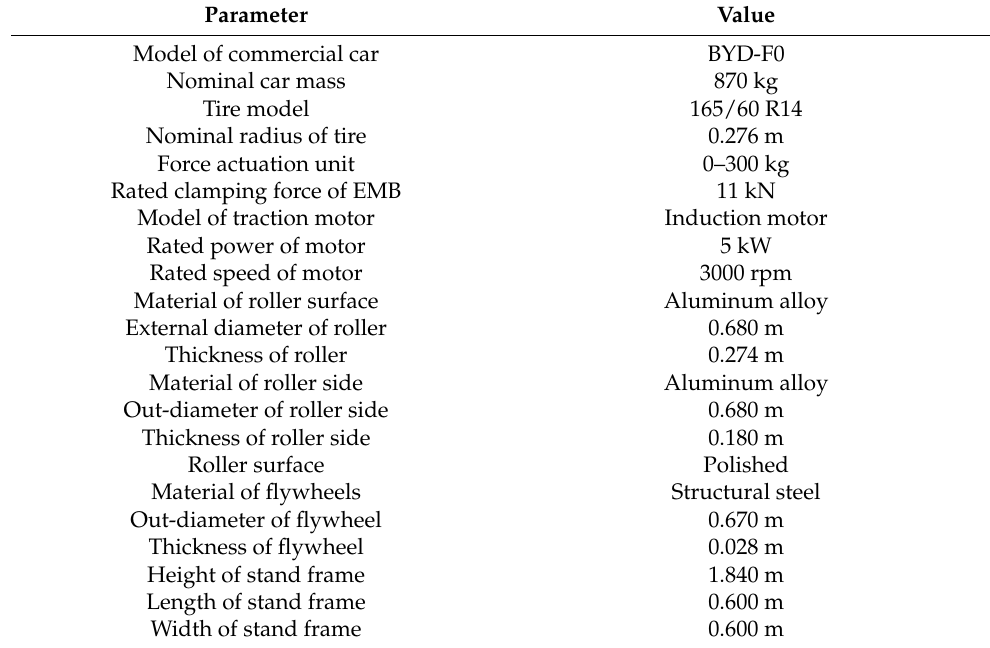
Table 1. Main parameters of developed